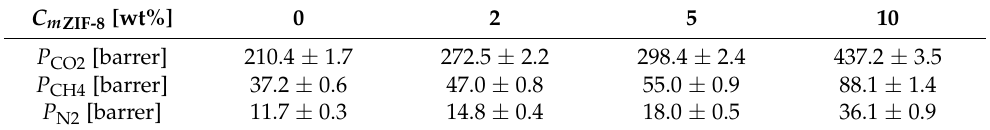
Table 4. Permeation coefficients P i of the test gases for membranes of different ZIF-8 concentrations.